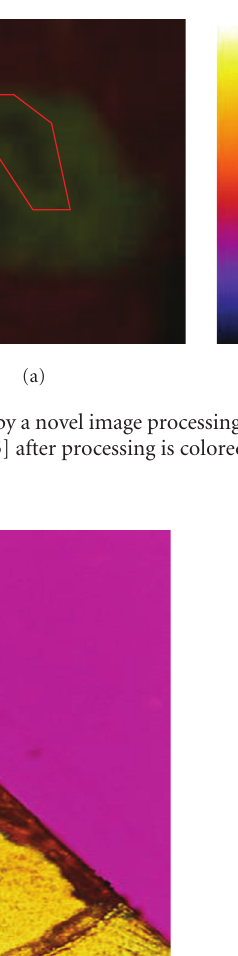
The statistical linear regression was applied to these data (Figure 5). The correlation coe ffi cient was 0.9696. The two- tailed t -test for coe ffi cient was 7.93, indicating the P -value = .0014. The F test for the entire model was 62.86, which shows the P -value = .0013. Thus, results show significant linear correlation between the demineralization depth ( X ) and fluorescence loss ( Y ) as Y = 0 . 32 X + 0 .